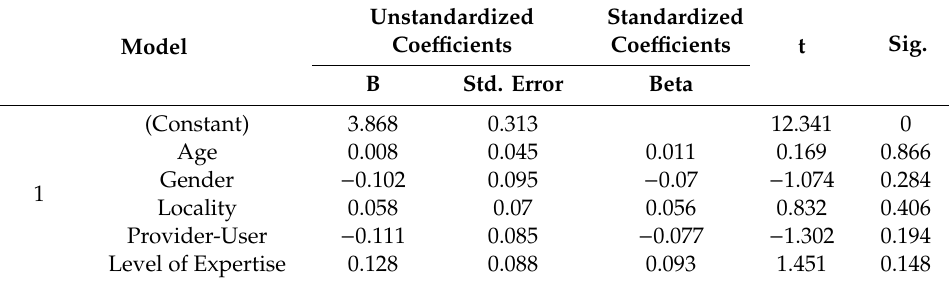
Table 5. Coe ffi cients a .